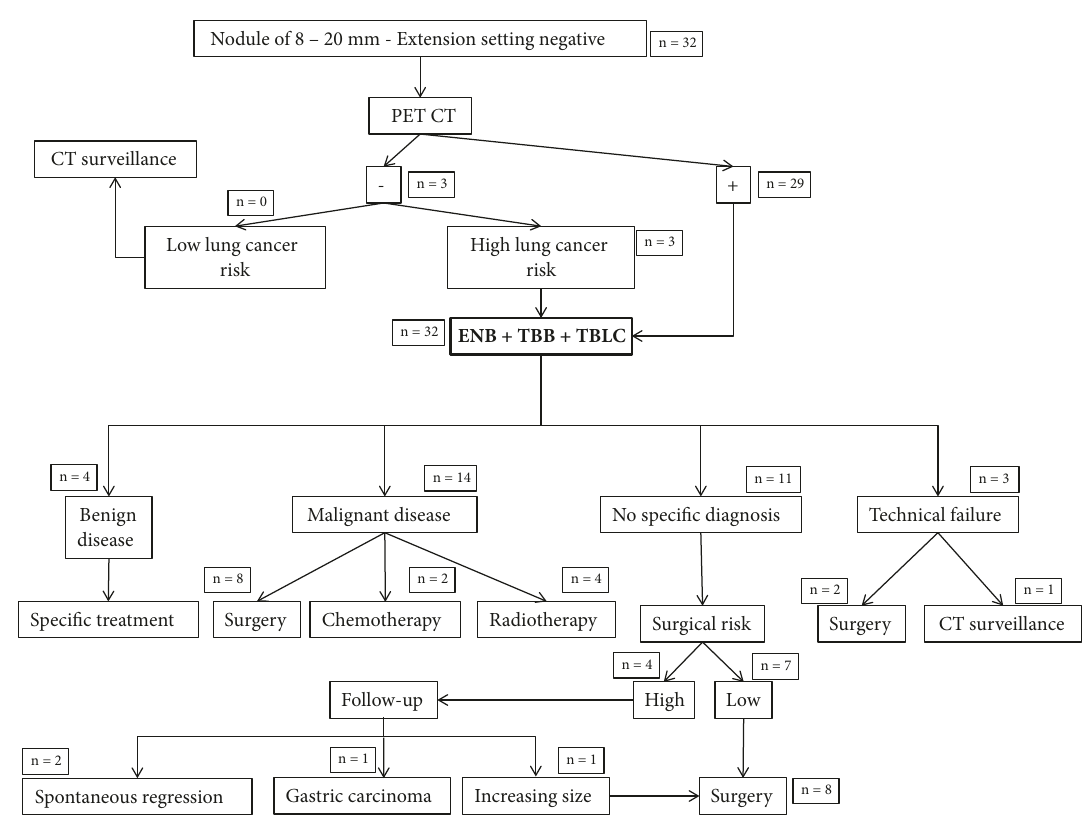
Figure 1: Flowchart summarizing the management of patients with pulmonary nodules from 8 to 20 mm in diameter without locoregional or distant metastasis with the frequencies in each category. Benign diseases consisted in tuberculosis in three patients, sarcoidosis in one patient, and cryptogenic organizing pneumonia in one patient. Abbreviations: ENB = electromagnetic navigation bronchoscopy; EBUS = endobronchial ultrasonography; TBB = transbronchial biopsy; TBLC = transbronchial lung